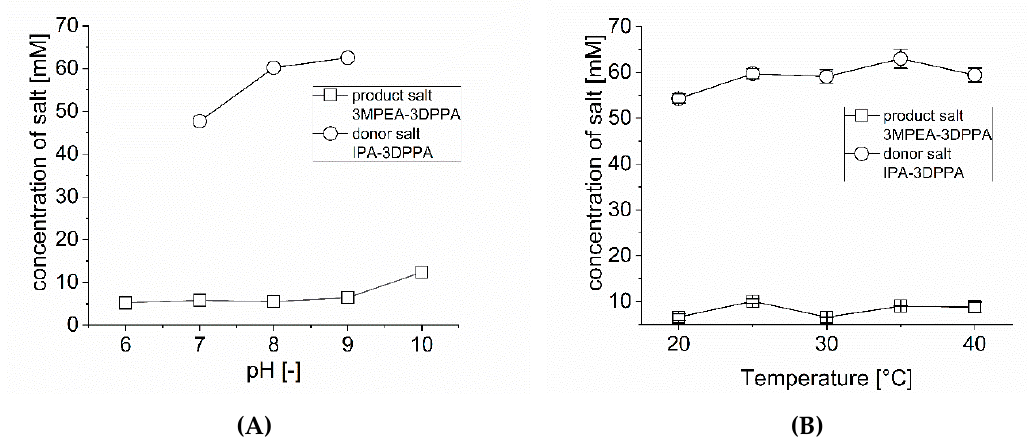
Figure 3. pH- and temperature-dependent solubility profile of the donor salt IPA-3DPPA and product salt 3MPEA-3DPPA; ( A ) pH dependency in 50 mM phosphate buffer at 30 °C; ( B ) temperature dependency in 25 mM HEPES buffer pH 7.5.